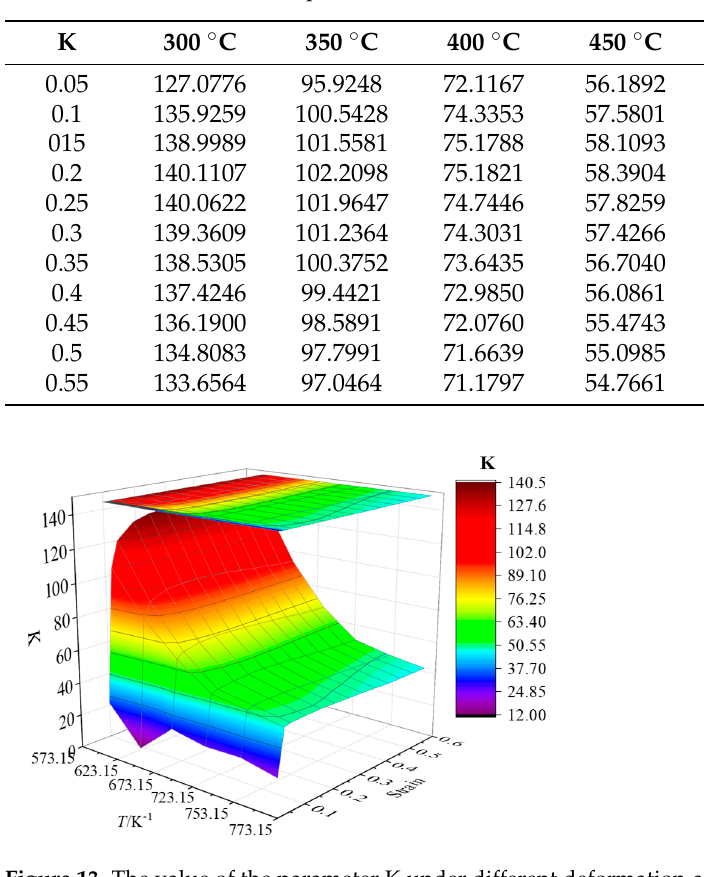
Figure 13. The value of the parameter K under different deformation condition.